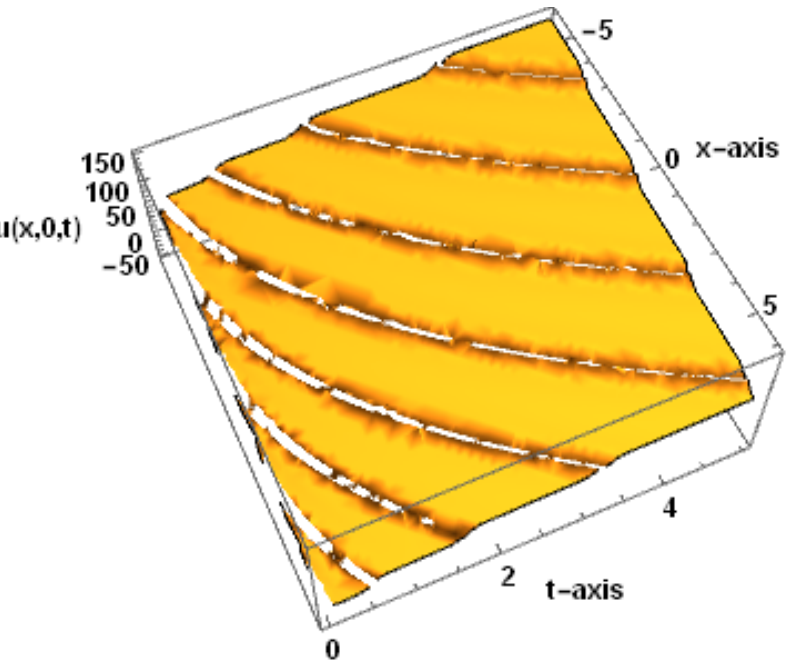
Figure 1. The 3D shape of the solution (24) indicates the singular periodic solitary wave solution for α = 2, β = 1, l = p = 1, λ = 4, µ = 5, A = 1, ρ 1 = 2, and θ = 0.5.